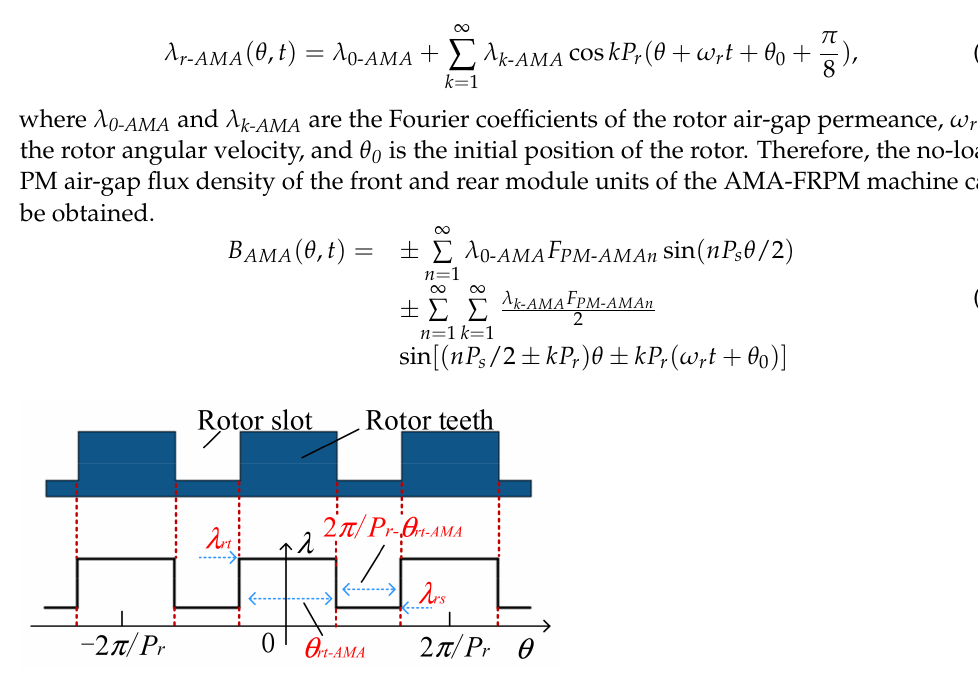
Figure 5. Permeance model for AMA-FRPM machine rotor